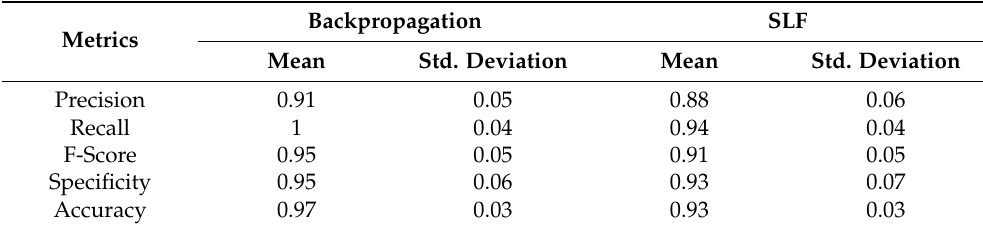
Table 6. Performance comparison of ANN model trained with backpropagation and